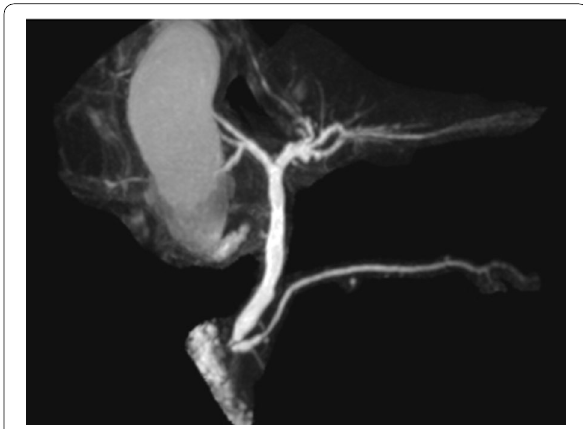
Fig. 2 Magnetic resonance cholangiopancreatography study after the administration of ceftriaxone. The base of the swollen gallbladder shows biliary sludge and stones. The common bile duct shows mild dilatation, but with no stones